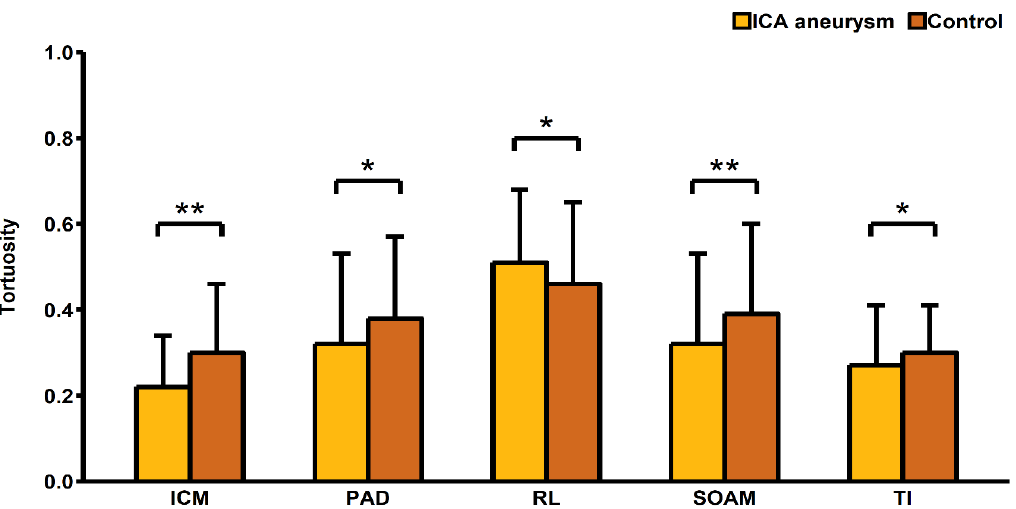
Figure 2. Comparison of tortuosity descriptors between patients with and without internal carotid artery aneurysm. ICA, internal carotid artery; RL, Relative Length; SOAM, Sum of Angle Metrics; PAD, Product of Angle Distance; TI, Triangular Index; ICM, Inflection Count Metrics; * p -value < 0.05; ** p -value < 0.01.